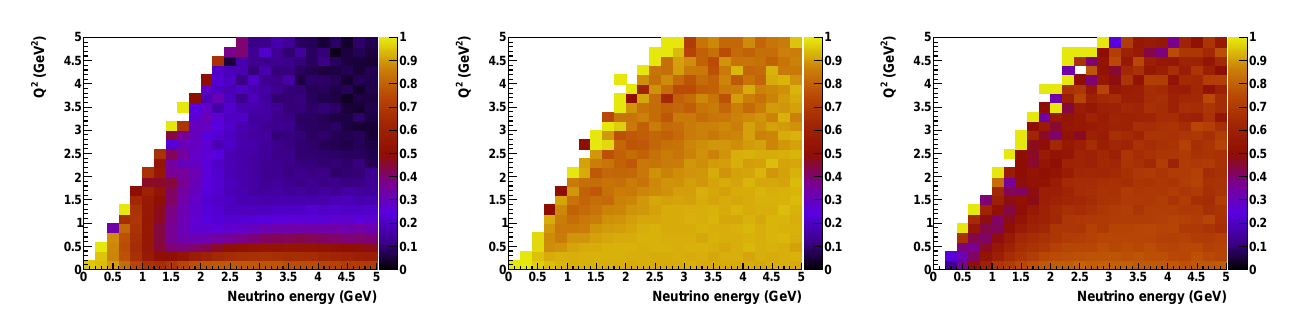
Figure 57. Comparison of the acceptance of ND-LAr ( left ), ND-GAr ( middle ), and the FD ( right ) for the range of neutrino energy and squared momentum transfer ( Q 2 ) of ν µ CC interactions expected at DUNE. ND-GAr and the FD are well-matched in their acceptance of events across the range of phase